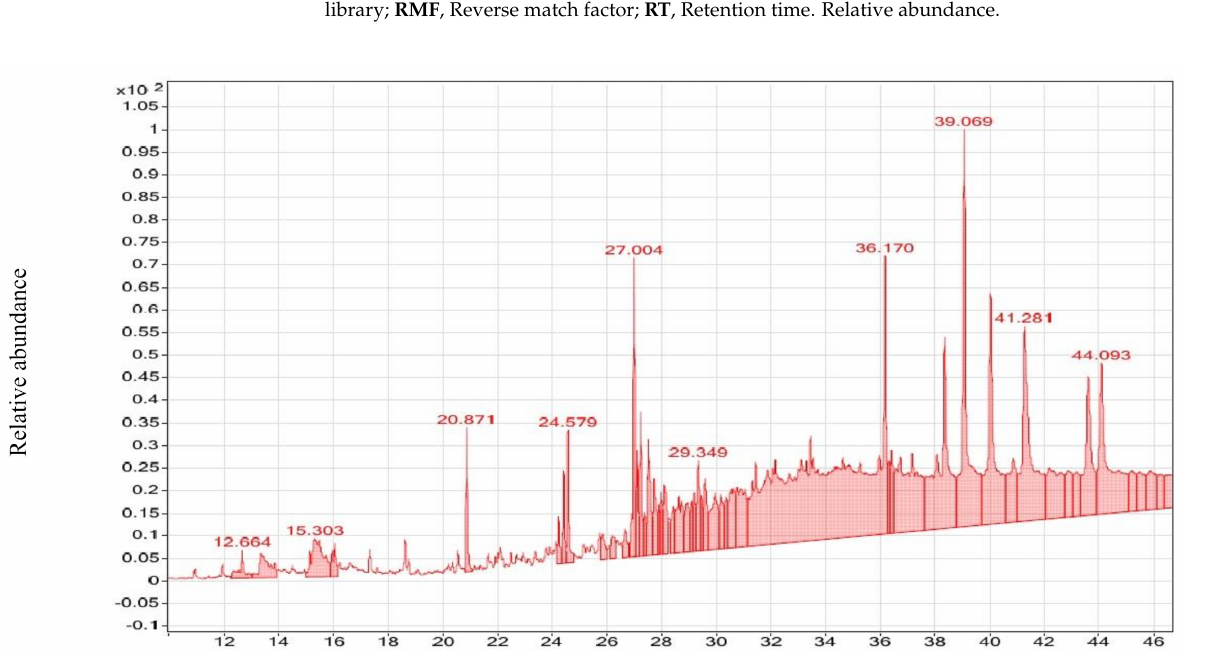
Figure 2. GC–MS chromatogram of Nm E.